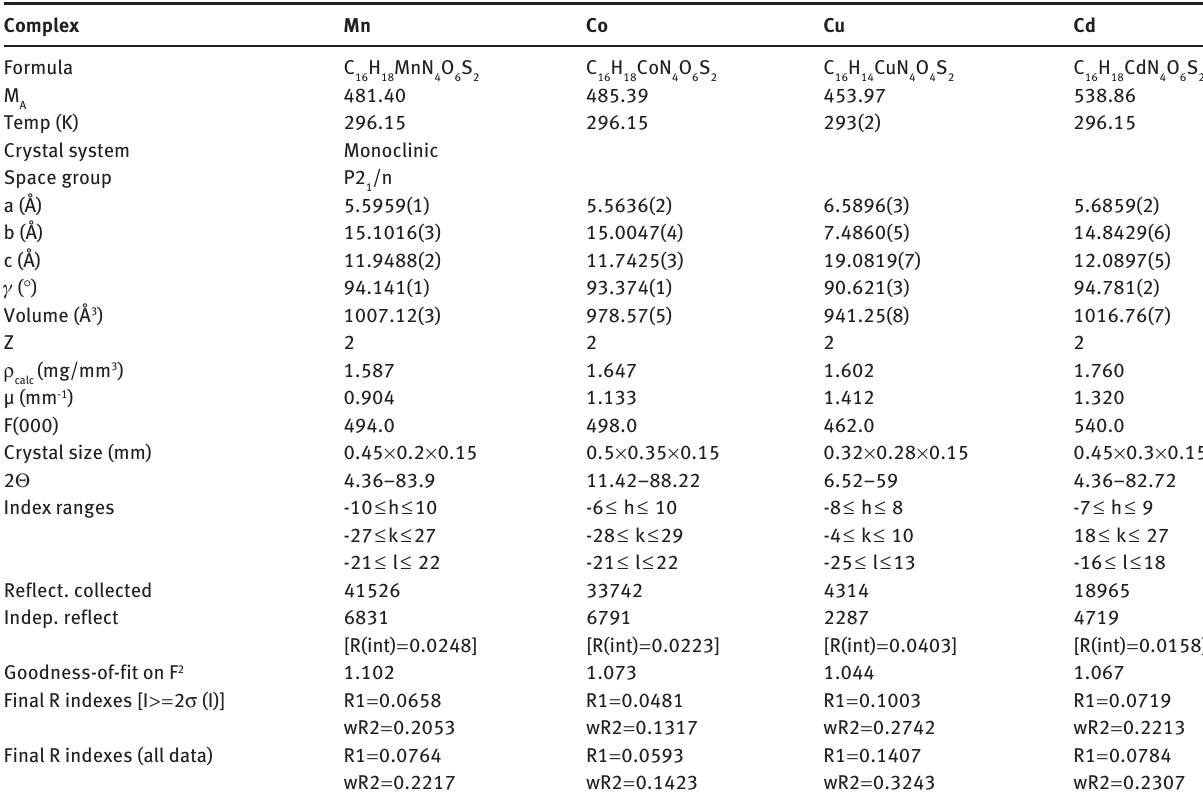
Table 1 Crystal and refinement data of the complexes. Complex